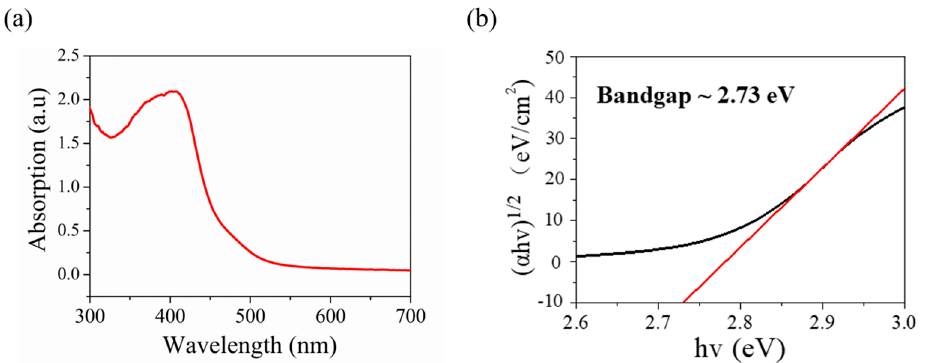
Figure 4. ( a ) UV − vis spectroscopy of synthesized V 2 O 5 nanosheets. ( b ) Tauc plot showing the optical band gap of 2.73 eV.